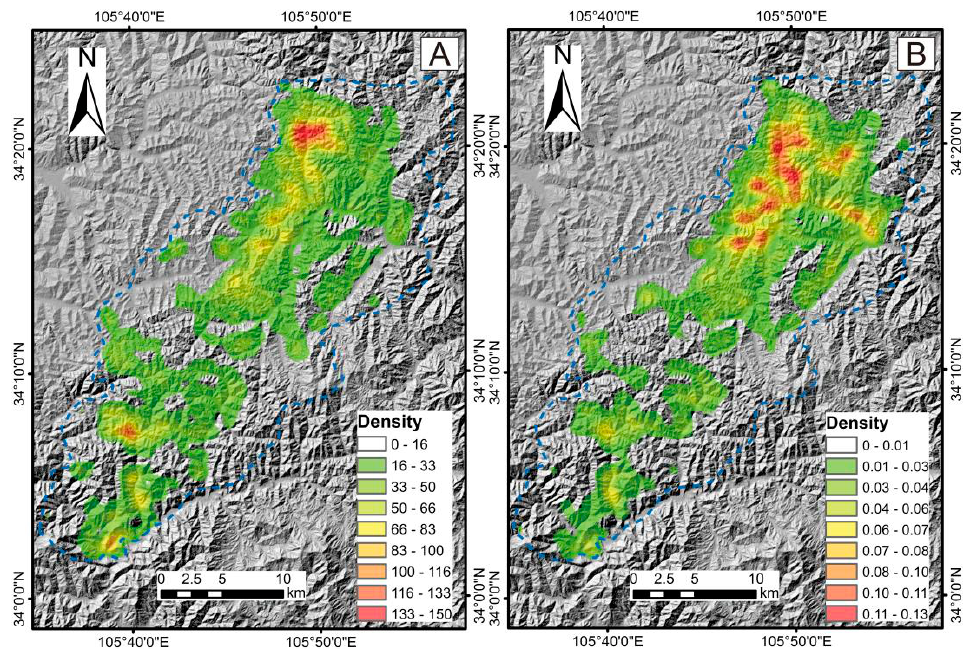
Figure 10. Kernel density analysis (search radius 1 km). ( A ) Non-weighted landslide density. ( B ) Area-weighted landslide density.